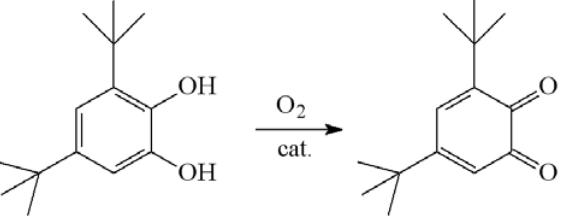
Fig. 7 Thermal decomposition (TG and DTA) curves of the montmorillonite-intercalated (Mont–i–Cu-tren) Cu-tren